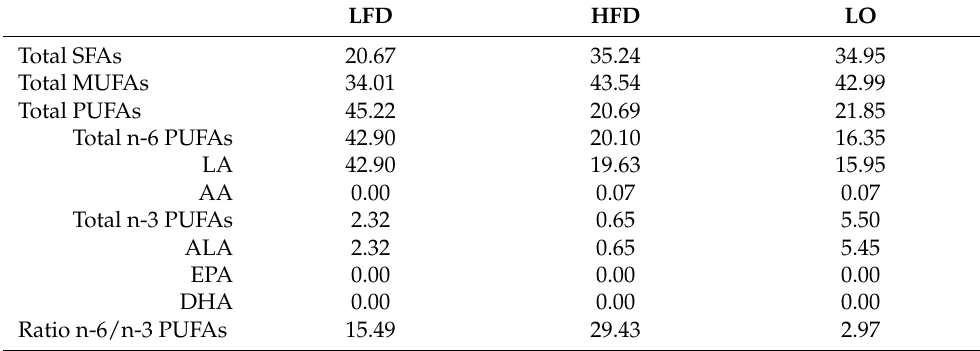
Table 1. Fatty acid content of the two diets (%). LFD: low-fat diet, HFD: high-fat diet, LO: linseed oil (for the LO groups: HFD + LO ± HIIT), SFA: saturated fatty acids, MUFAs: monounsaturated fatty acids, PUFAs: polyunsaturated fatty acids, LA: linoleic acid (C18:2 n-6), AA: arachidonic acid (C22:4 n-6), ALA: α -linolenic acid (C18:3 n-3), EPA: eicosapentaenoic acid (C20:5 n-3), DHA: docosahexaenoic acid (C22:6 n-3).